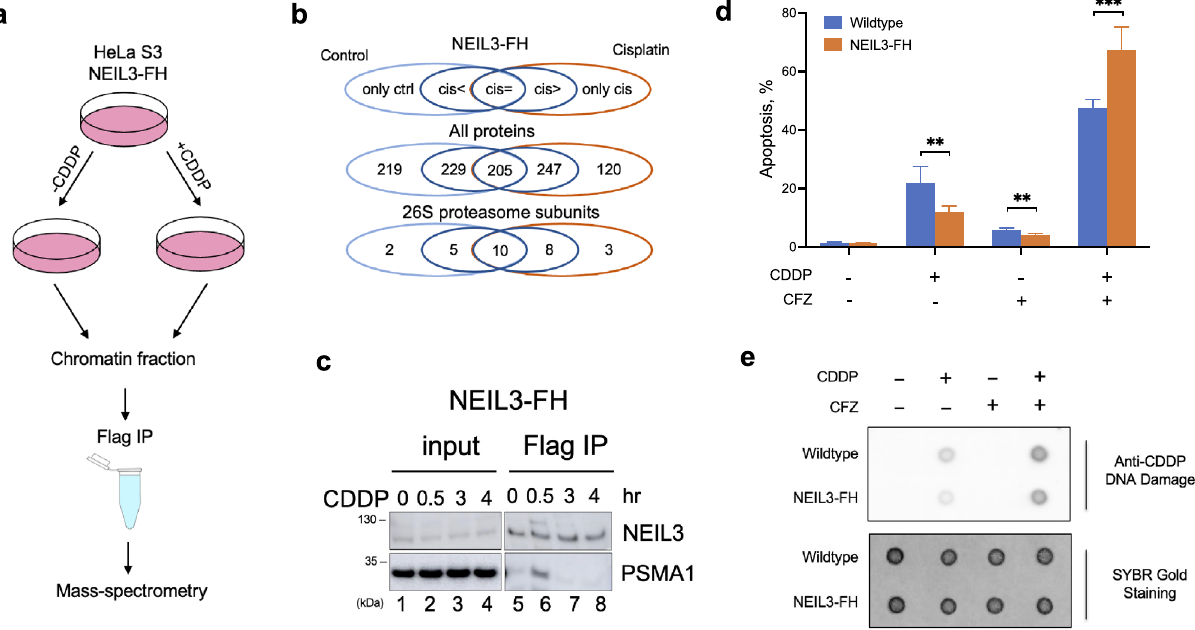
Figure 2. 26S proteasome plays a role in the NEIL3-mediated removal of cisplatin–DNA adducts. ( a ) Schematic outline of the mass-spectrometry analysis of Flag IP samples performed before and after 30 min treatment of HeLa S3 NEIL3-FH cells with 15 µg/mL cisplatin. ( b ) Venn diagrams representing the results of mass-spectrometry: “only ctrl” denotes proteins found in control non-treated cells; “cis < ” and “cis > ” indicate proteins that increase or decrease, respectively, after cisplatin treatment; “cis = ” refers to proteins that do not change after the treatment; “only cis” designates proteins that are detected only after the treatment. ( c ) Western blot of Flag IP samples purified from chromatin fractions of NEIL3-FH cells treated with cisplatin (CDDP, 15 µg/mL) for the indicated period of time. Note that the membrane was cropped to remove irrelevant parts. ( d ) Measurement of apoptosis by flow cytometry of Annexin V and Propidium Iodide (PI) stained cells pretreated with 0.5 µM CFZ followed by overnight incubation with different doses of CDDP. Data shown are the mean ± SD (n = 3). ** p < 0.01; *** p < 0.001. ( e ) Dot blot with an antibody recognizing cisplatin-modified DNA to measure the accumulation of cisplatin–DNA adducts after the pretreatment with 0.5 µM CFZ followed by overnight exposure to CDDP (15 µg/mL). SYBR Gold staining was used as a loading control. See Materials and Methods for additional